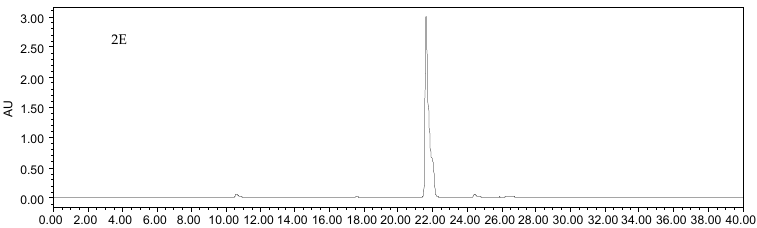
Figure 2. ( A ) HPLC chromatogram of the enriched sample from SLHC, which were isolated with the mixed solvents of dichloromethane–methanol; ( B ) HPLC chromatogram of the enriched sample from SLHC, which were isolated with isocratic 60% methanol; ( C ) HPLC chromatogram of the enriched sample from SLHC, which were isolated with a gradient methanol–water; ( D ) HPLC chromatogram of HSCCC peak fraction 1 in Figure 3; ( E ) HPLC chromatogram of HSCCC peak fraction 2 in Figure 3; Experimental conditions: column, a YMC-Pack ODS A column (5 μ m, 250 mm × 4.6 mm); mobile phase, methanol (C) and 0.1% trifluoroacetic acid (D) at the gradient (20%–65% C at 0–20 min, 65%–100% C at 20–40 min); flow rate, 1.0 mL·min − 1 ; detection wavelength, 254 nm; column temperature, 35 °C.